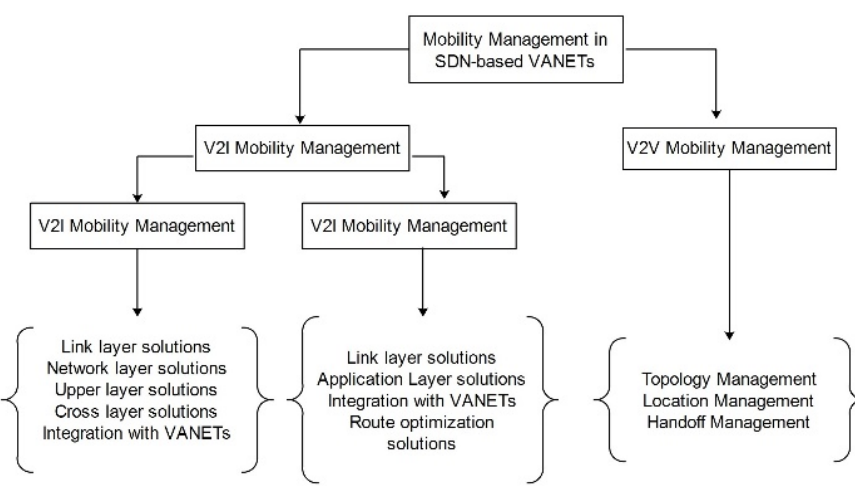
Figure 23. Mobility management in SDN-based VANETs.